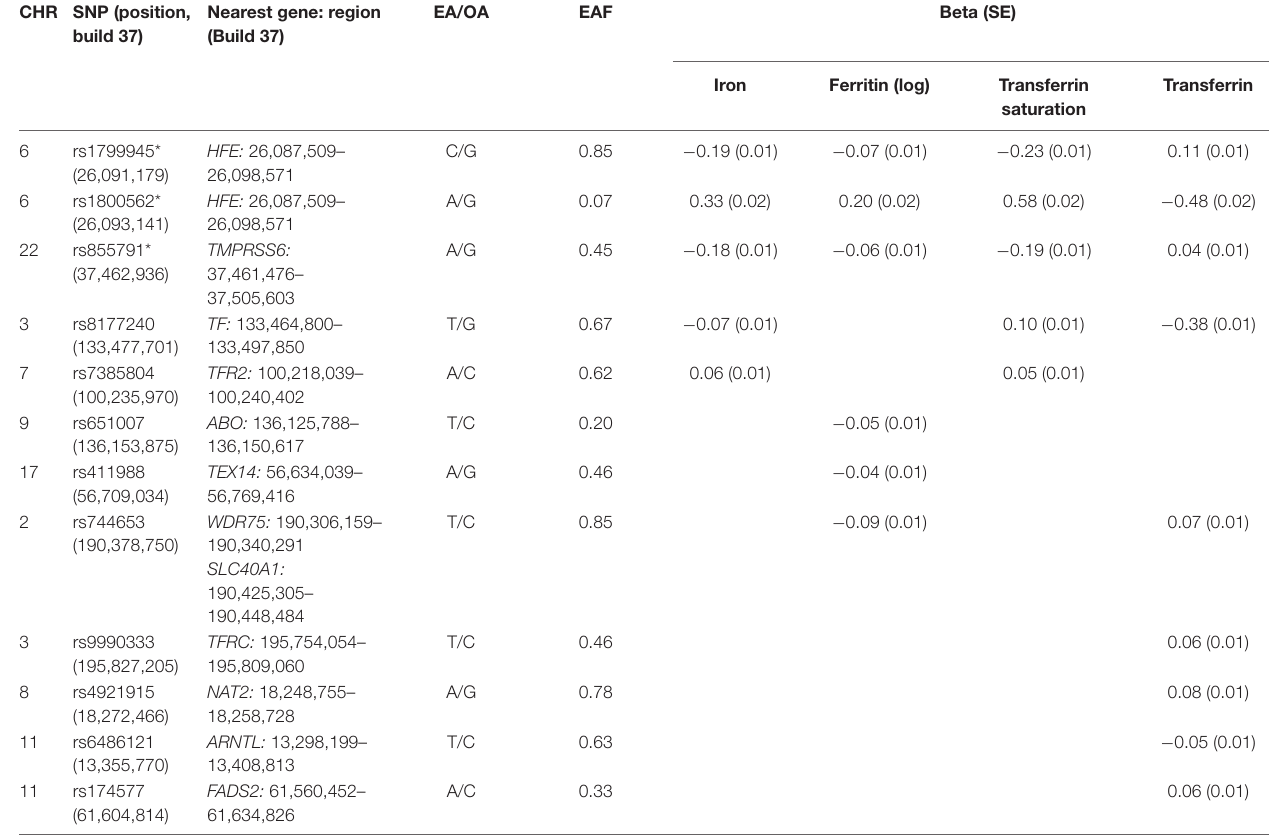
TABLE 1 | Association estimates for SNPs associated with biomarkers of iron status at genome-wide significance ( p < 5 × 10 − 8 ) identified from GIS consortium. CHR SNP (position, Nearest gene: region EA/OA EAF Beta (SE) build 37) (Build 37)